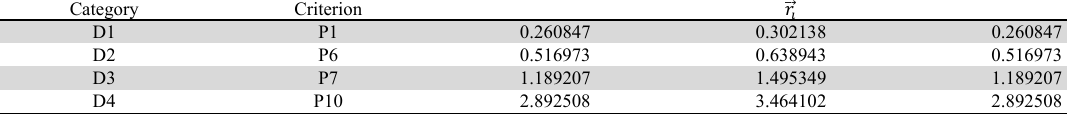
Triangular geometric mean of each analyzed criterion Category Criterion